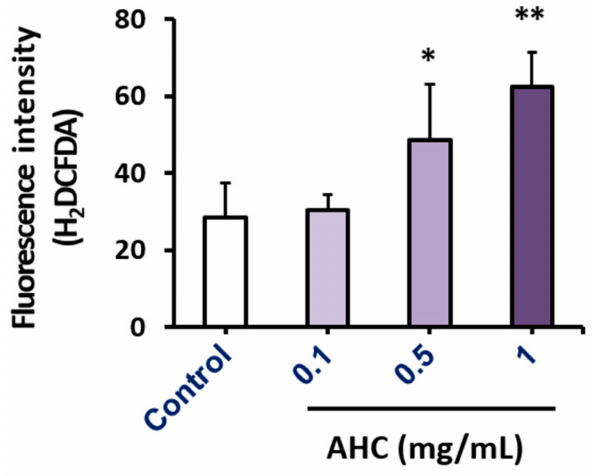
Figure 6. E ff ects of the AHC extract on ROS generation in MCF-7 cells. Level of ROS generation by AHC after 24 h treatment was monitored by flow cytometry. Control: 0.1% DMSO in culture medium. Data of * p < 0.5 and ** p < 0.05 vs.